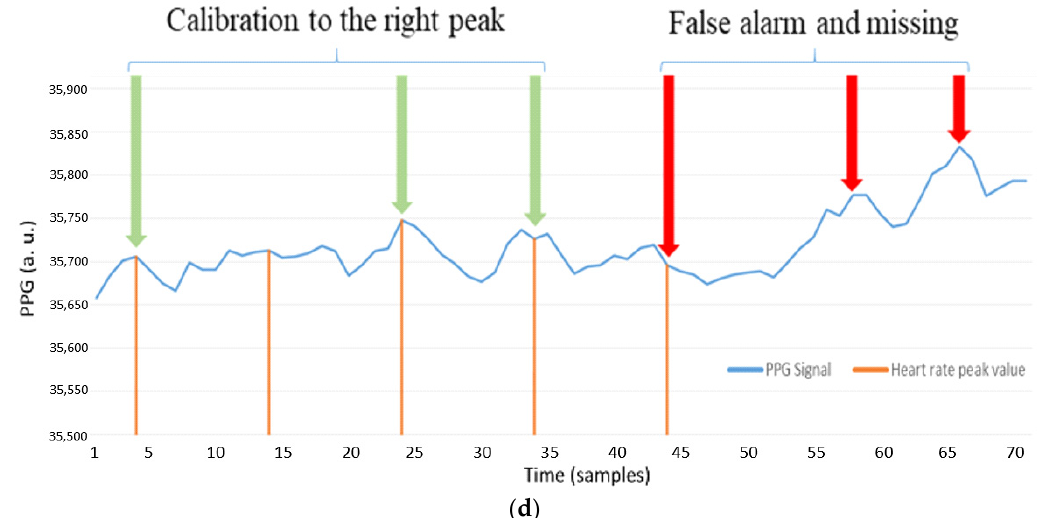
Figure 8. ( a ) Static fingertip PPG signal using the AMPD algorithm with Laplacian (Threshold = 4/L, L = 7); ( b ) Static wrist PPG signal using AMPD algorithm with Laplacian (Threshold = 4/L, L = 7); ( c ) Dynamic wrist PPG signal using AMPD algorithm with Laplacian (Threshold = 4/L, L = 7); ( d ) Static wrist PPG signal using AMPD–BL (Threshold = 3/L, L = 7).